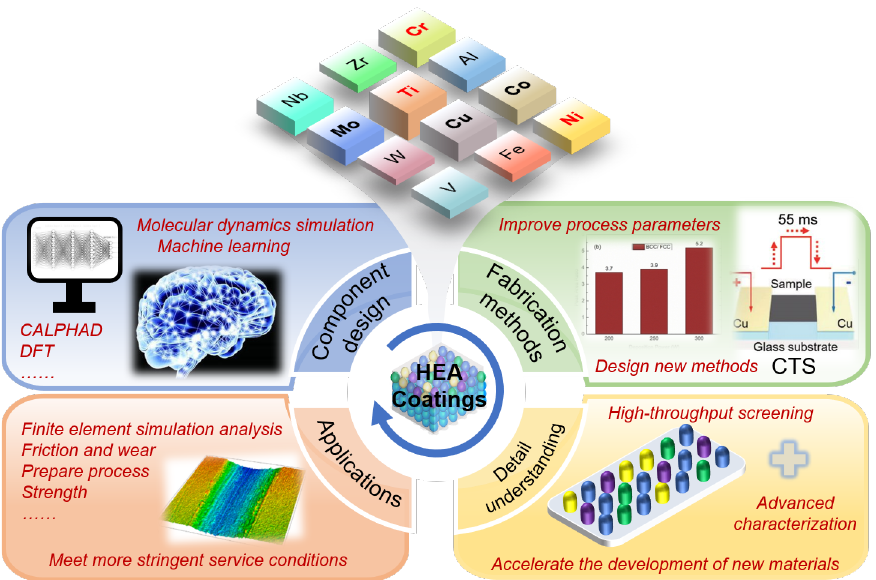
Figure 13. The schematic diagram of the future development of HEA coatings based on composition–process–understanding–application, especially in the following three aspects: high-throughput screening and multi-scale simulation accelerated material development, systematic research on the design, development and basic theory of new HEA and HEA coatings, optimization of the preparation process of HEA coatings, and design of new